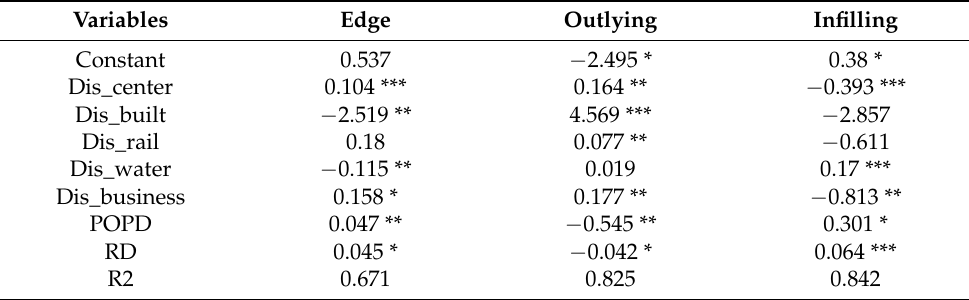
Table 2. Three group variable coefficients for edge, outlying, and infilling.